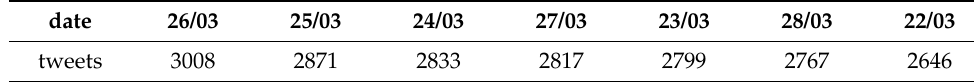
Table 7. Highest game-related tweeting per day.